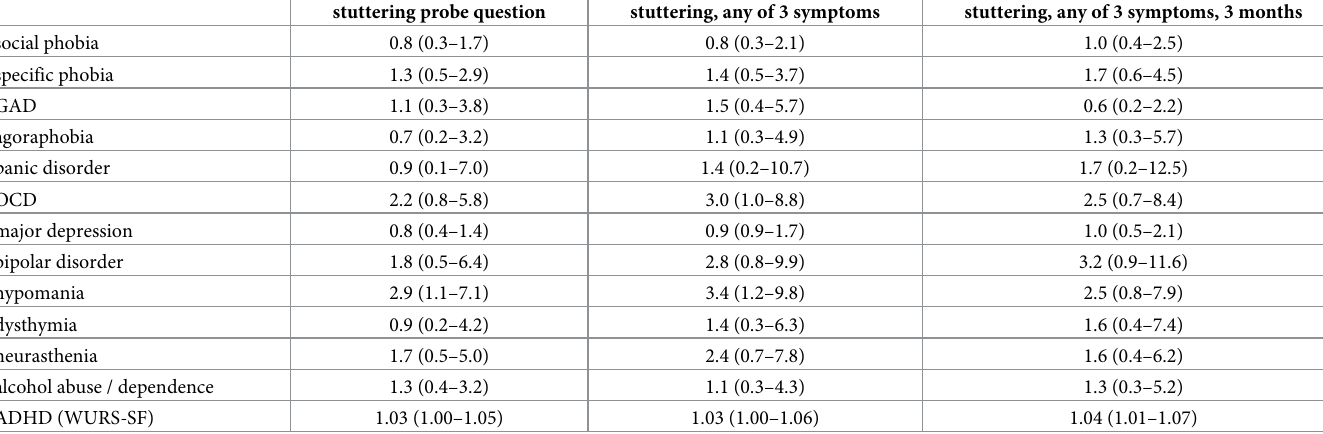
Table 4. ZInEP: Associations between stuttering and common mental disorders. Odds ratios and confidence intervals (95%), adjusted for sex. stuttering probe